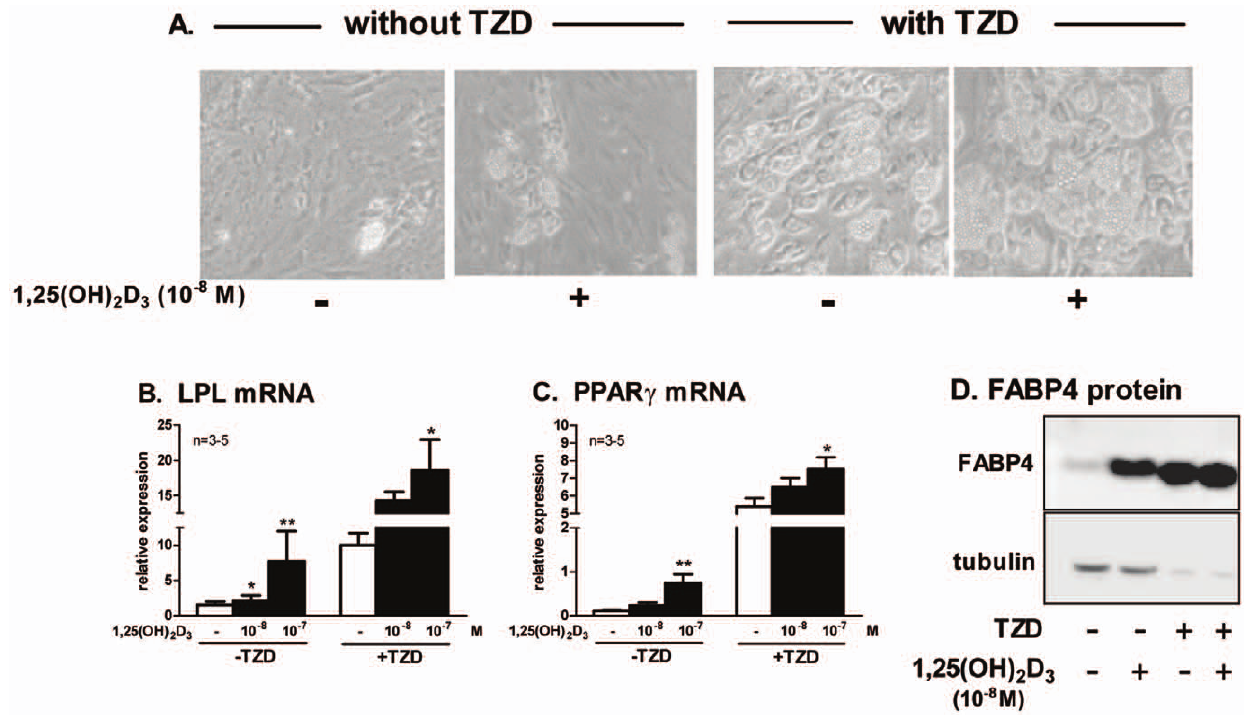
Figure 6. The pro-adipogenic effects of 1,25(OH) 2 D 3 were independent of thiazolidinedione treatment. Human preadipocytes were differentiated in the differentiation cocktail with or without thiazolidinedione (TZD) for 7 days and maintained in maintenance media until harvest. 1,25(OH) 2 D 3 or vehicle control was present throughout. Phase contrast image of adipocytes were taken at day 13 after differentiation (A). Expression levels of adipogenic markers [LPL (B) and PPAR c (C) mRNA and FABP4 (D) protein] were measured after differentiation (d13–14). Lane 3 and 4 (differentiated in the presence of TZD) were intentionally under loaded to show the results in the same blot. *, p , 0.05, **, p , 0.01, vehicle control vs. 1,25(OH) 2 D 3 treatment, n=3 for 10 2 8 and n=5 for 10 2 7 M.